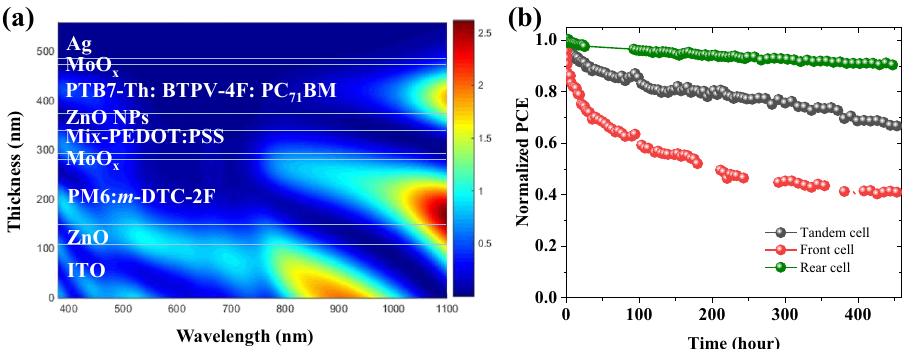
Fig. 7 Light- fi eld analysis and and long-term photostability test. a The light- fi eld distribution of the tandem OSC (140 nm for front sub-cell and 100 nm for rear sub-cell). b Long-term photostability test for the tandem solar cells and two sub-cells under continuous AM1.5 100 mW cm − 2